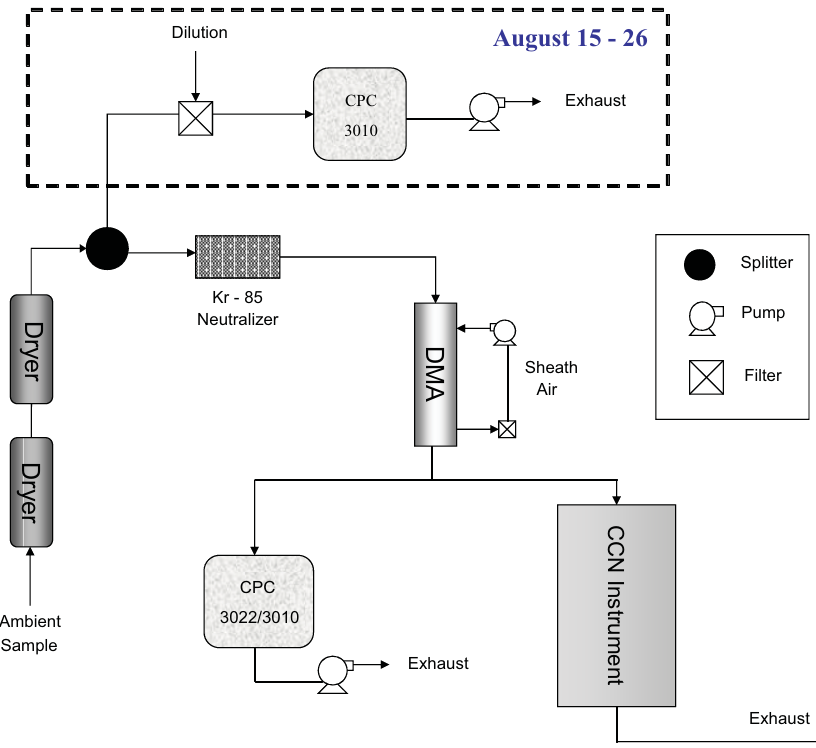
Fig. 3. AMIGAS experimental set up. From 1 till 26 August, the CPC 3022A was used for the SMPS; while the CPC 3010 was used from 26 August till the end of the campaign (15 September). The sheath-to-aerosol ratio in the DMA was run at 10:1 (1 till 8 August; Setup A1) and 5:1 (8 August till 15 September; Setup A2 and B). The dotted box highlights the total CN measurement which was done from 15 till 26 August with the